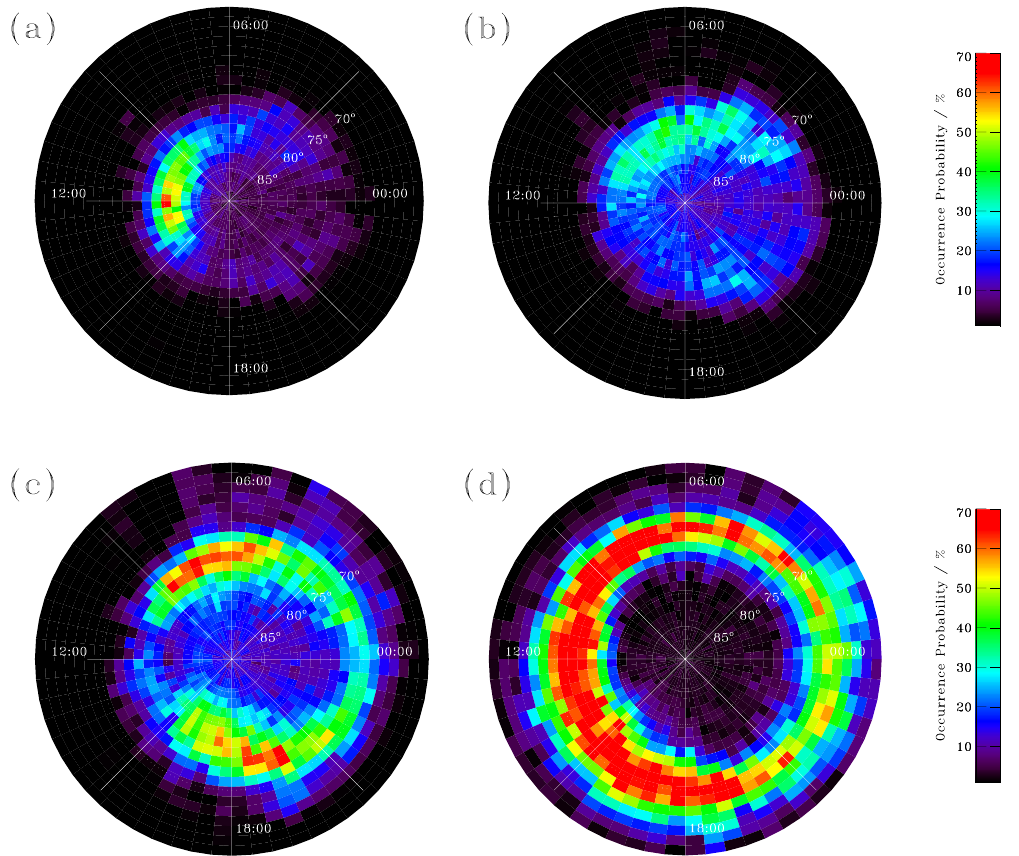
Fig. 2. The occurrence probability of ions in the magnetosphere plotted as invariant latitude ( 3 ) versus magnetic local time (MLT) in polar coordinates. Occurrence probabilities for energy ranges: (a) 0.9–1.1keV, (b) 1.2–2.6keV, (c) 2.9–8.0keV and (d) 9.1–25.2keV. The peak in the DCR (total ion signature) differential energy flux spectrum ( J E ) is used to determine a characteristic energy for each integration period. 3 ranges from 60 ◦ to 90 ◦ for all MLTs with a bin size of 1.5 ◦ by 24 min. Each bin has a 50-sample threshold to ensure reliable statistics. Data has been taken for all interplanetary conditions. CAMMICE data used in this plot was taken almost continuously from 18 March 1996 to 31 March